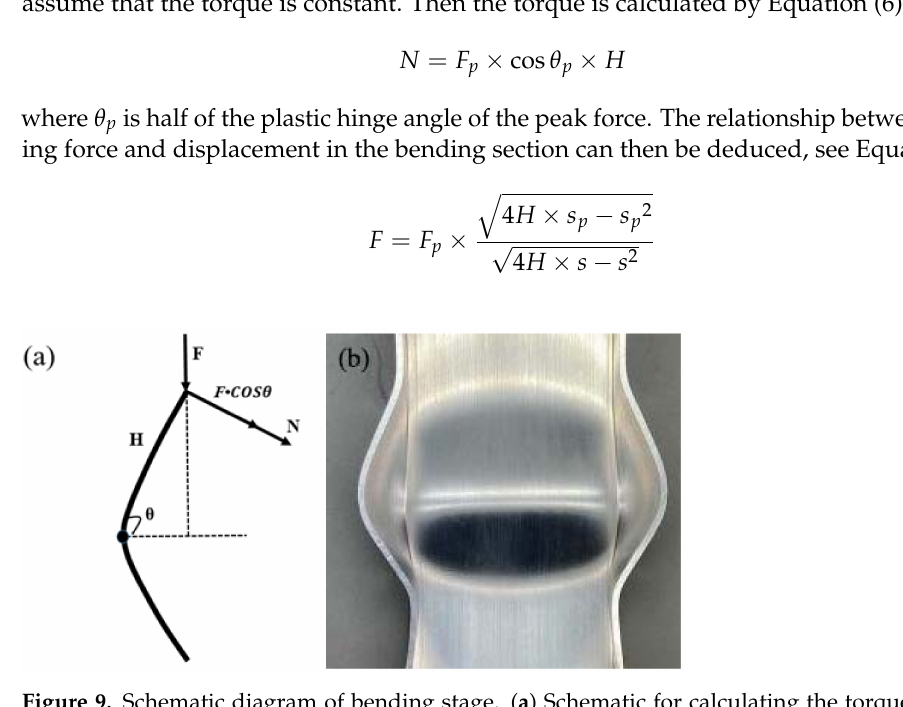
Figure 9. Schematic diagram of bending stage. ( a ) Schematic for calculating the torque, ( b ) A-A section photo of crushing 10 mm.